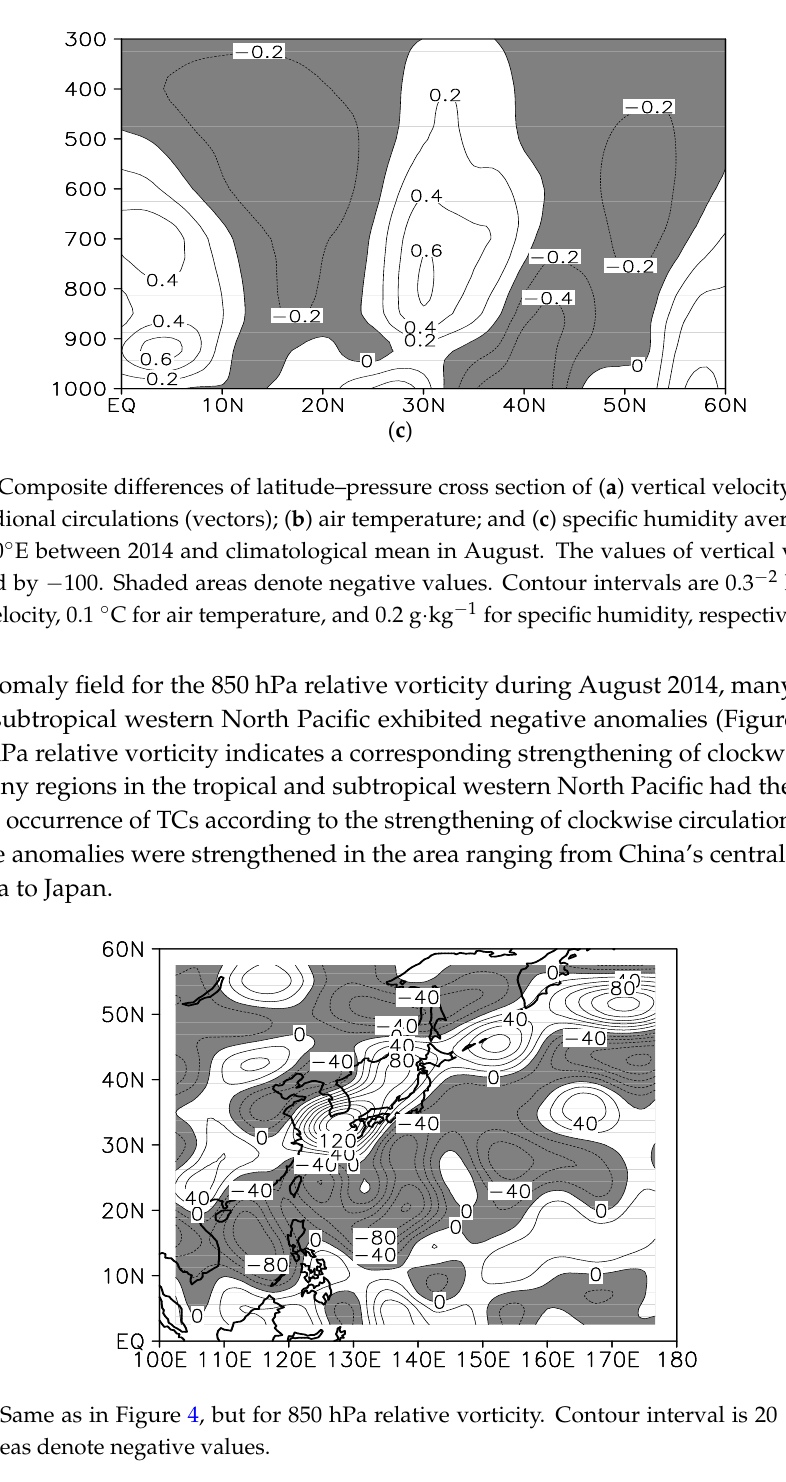
Figure 8. Same as in Figure 4, but for 850 hPa relative vorticity. Contour interval is 20 × 10 −6 s −1 . Shaded areas denote negative values.